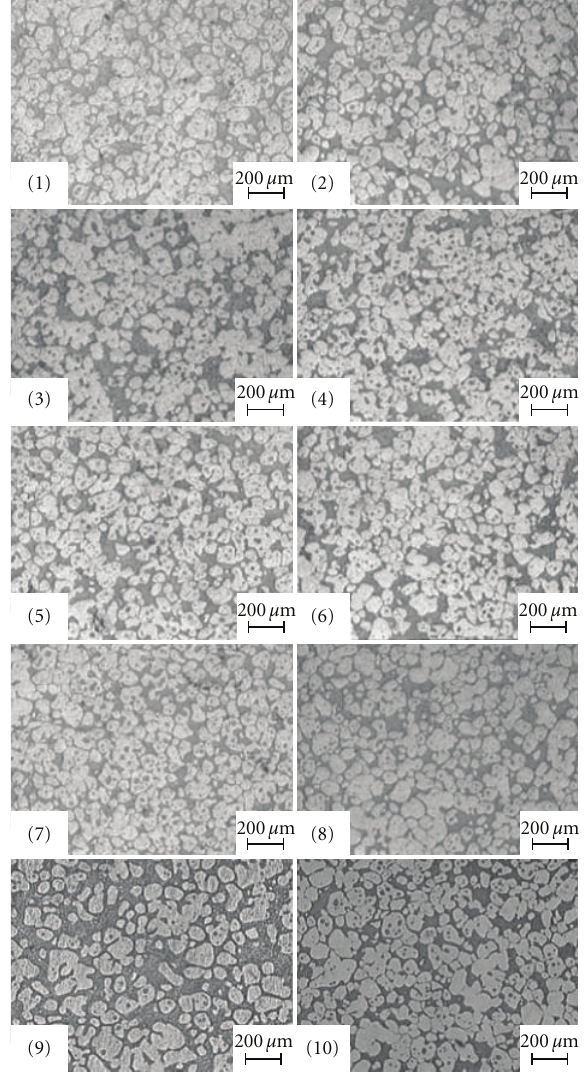
Figure 8: Microstructures at each position according to each point ( C = 60A, ts = 10s and solid fraction of